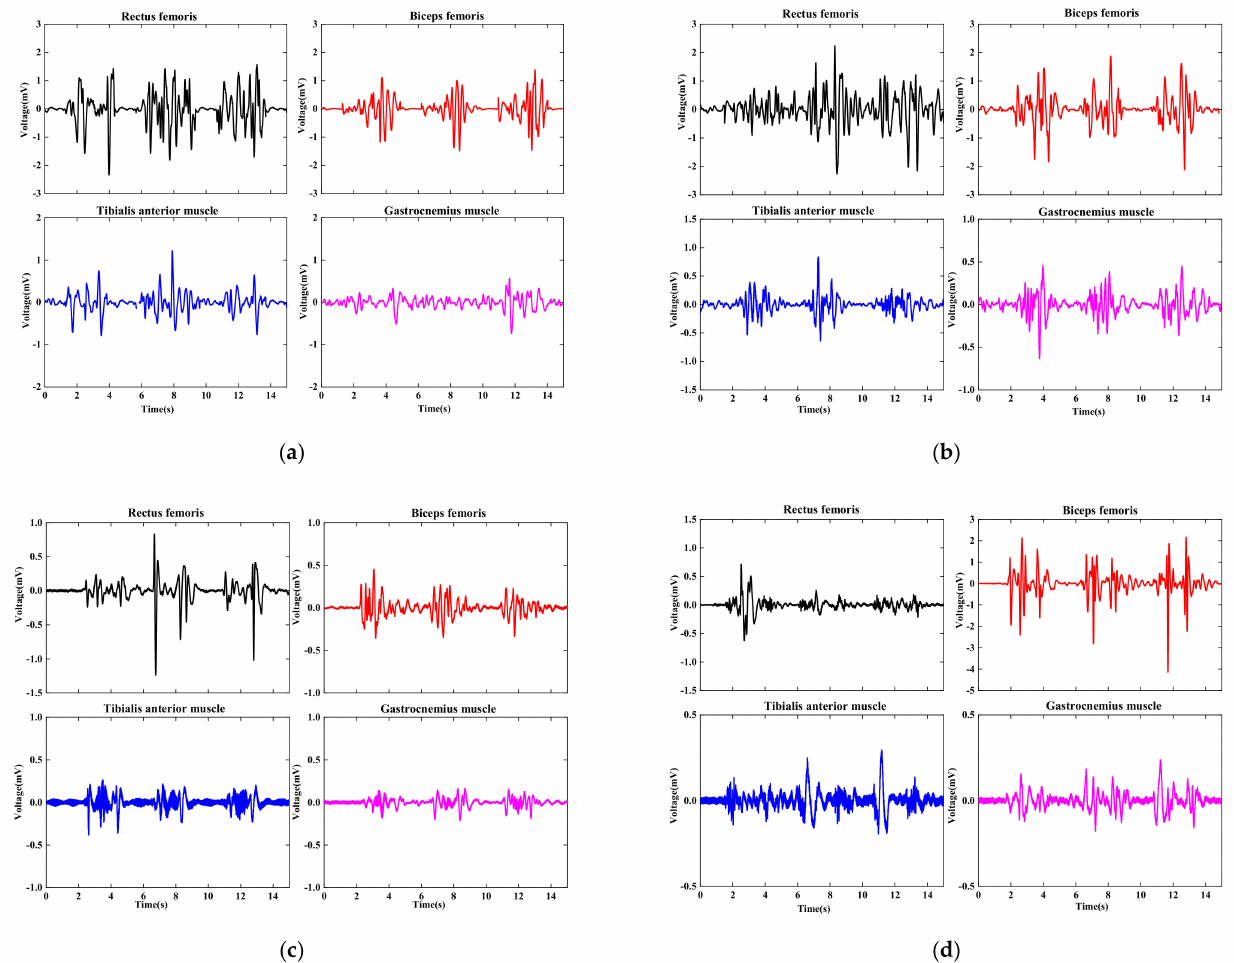
Figure 17. EMG of the lower limb in different movement. ( a ) Squatting; ( b ) lunging; ( c ) raising the leg; ( d ) standing